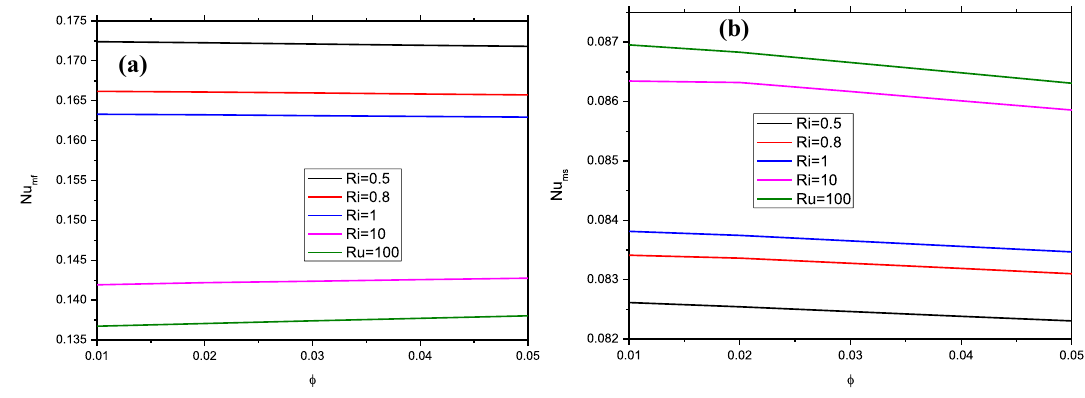
Fig. 17 Richardson number profiles of the average Nusselt number of fluid phase (left) and solid phase (right) for TiO Nanofluid at Ha = 10 , Q = 1 , Da = 10 – 3 , Gr